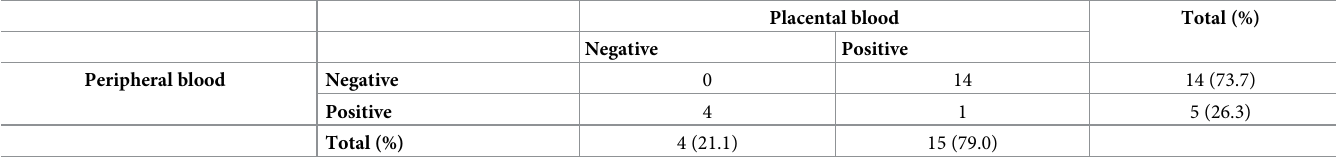
Table 10. Paired peripheral and placental samples of mono-infection of P . malariae